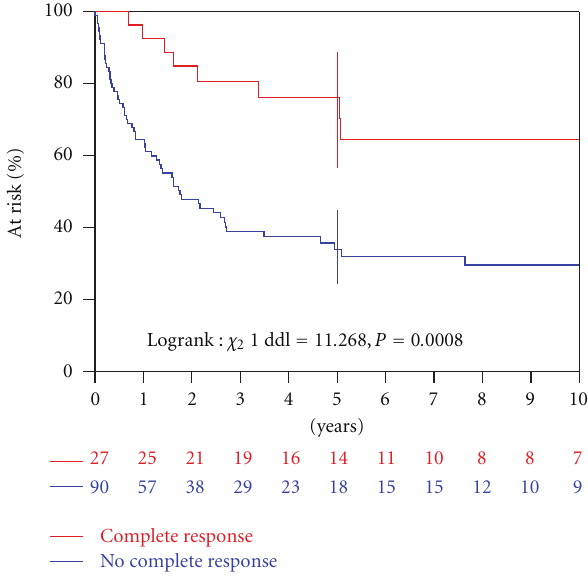
Figure 2: Overall survival according to the early response to sandwich